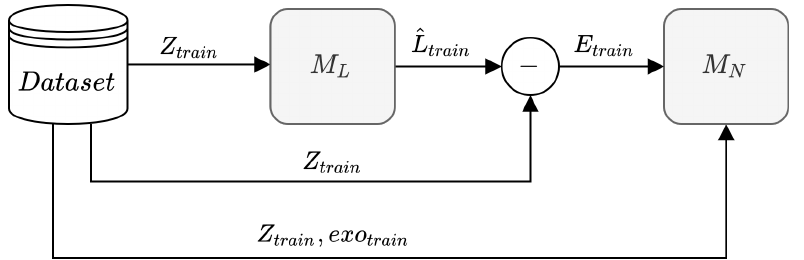
Figure 1. H-Transformer training step.